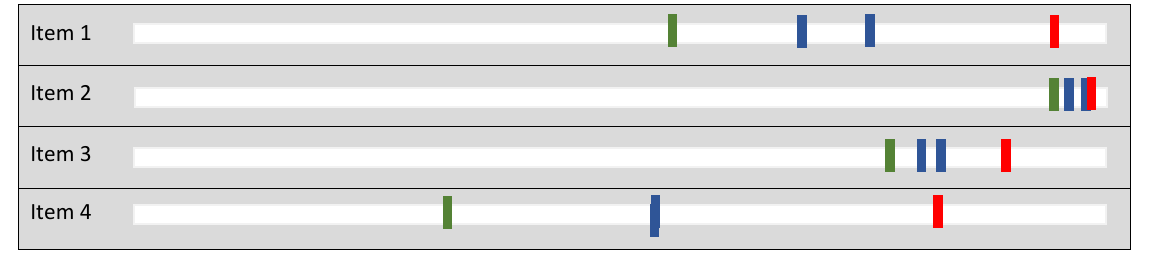
Figure 4. Example of answers collected from a computerized application using a fuzzy rating scale that generates trape- zoidal